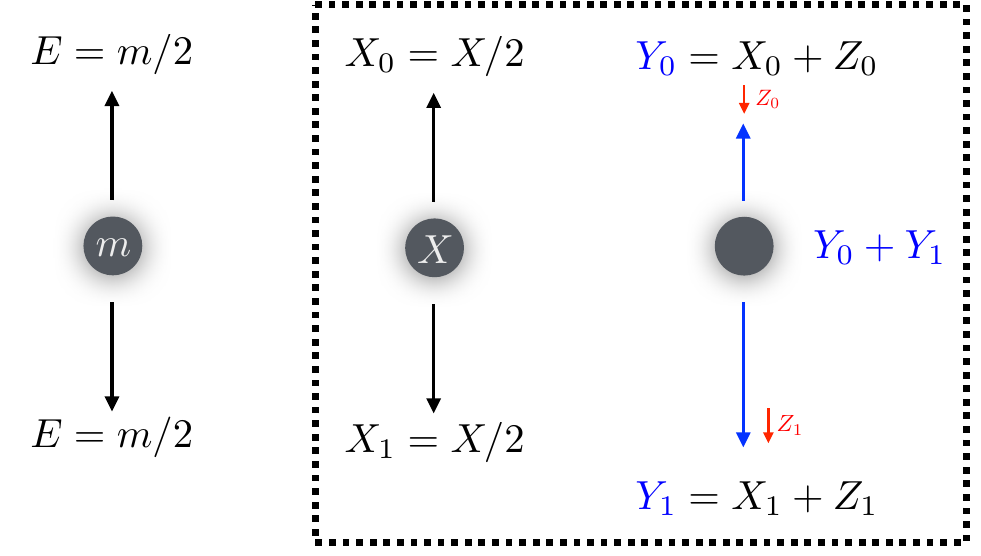
Figure 1: A schematic diagram of the illustrative model. An actual two-body decay in the parent particle rest frame is shown on the left. In the simple example, the two energies are collinear and detector effects ( Z the